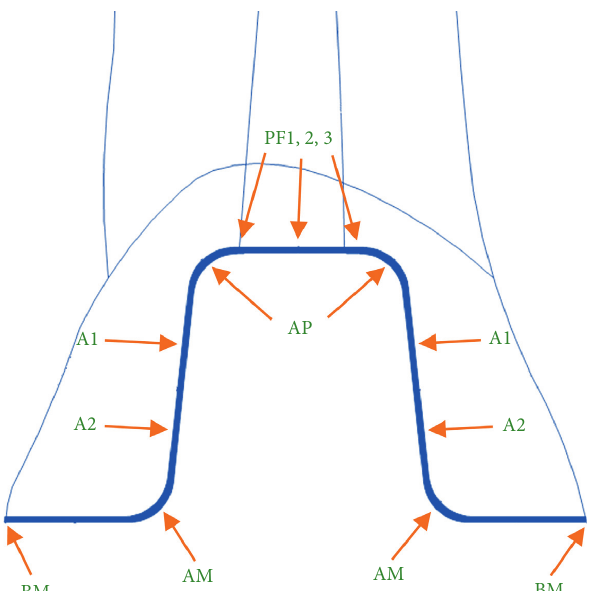
Figure 3: Schematic drawing showing points assessed in the replica technique (PF, pulpal floor; AP, axiopulpal angle; A, Axial wall; AM, axiomarginal angle; BM, butt margin).